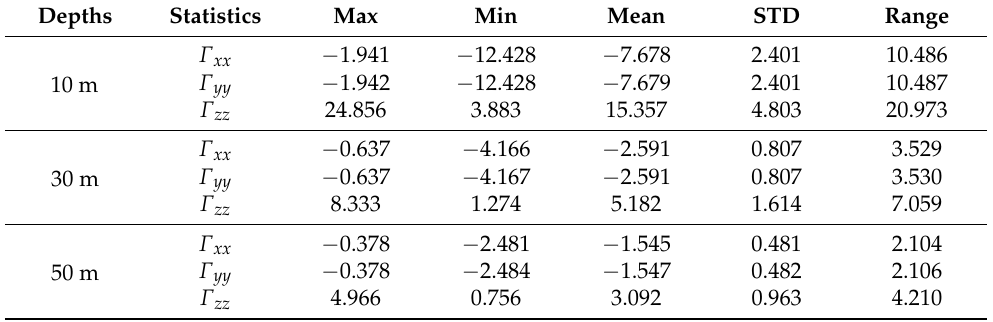
Figure 10. Annual range of the disturbing gravity gradient at 10 m below the mean sea level ( Γ xx and Γ yy are both negative, and the absolute values shown in ( a , b ). Γ zz is positive in ( c ). (unit: E).